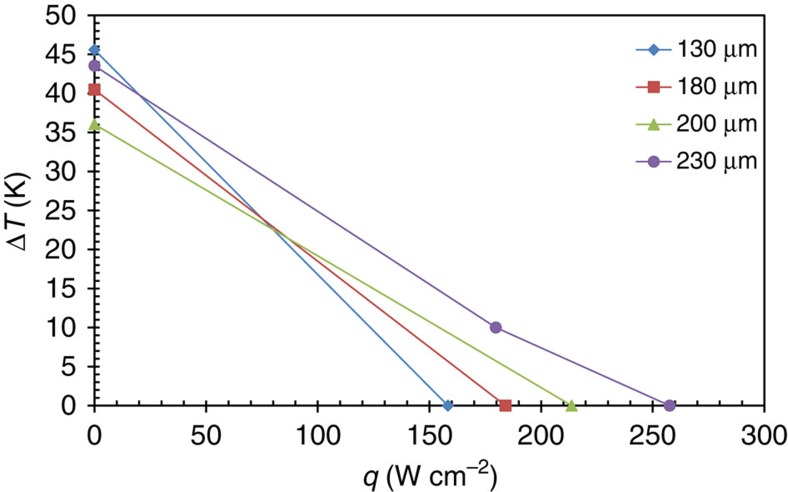
Load lines for each of the four measured modules of this work.The load lines are determined by the measurement of qmax at ΔT=0K, and the measurement of ΔTmax at q=0 W m−2. An additional data point for the case of ΔT=10 °C is included for the module with the largest contact diameter (230 μm).